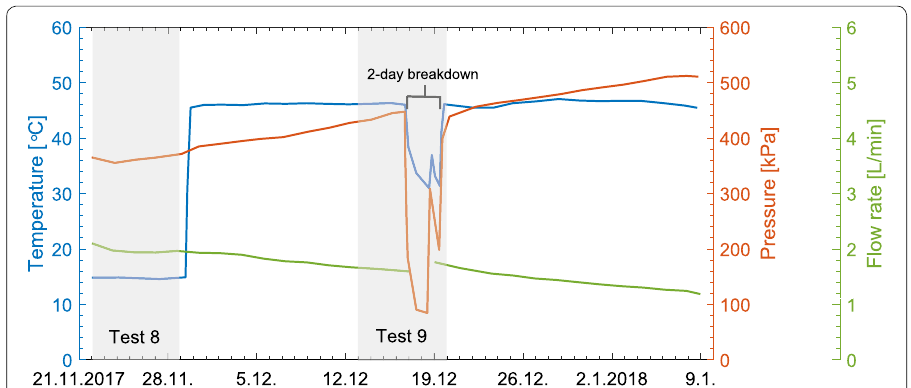
Fig. 2 Fluid injection temperature, pressure, and flow rate during fluid injection into INJ2‑int4 (modified from Doetsch et al. 2018). It is worth noting that the system was likely not yet at steady‑state during Test 8